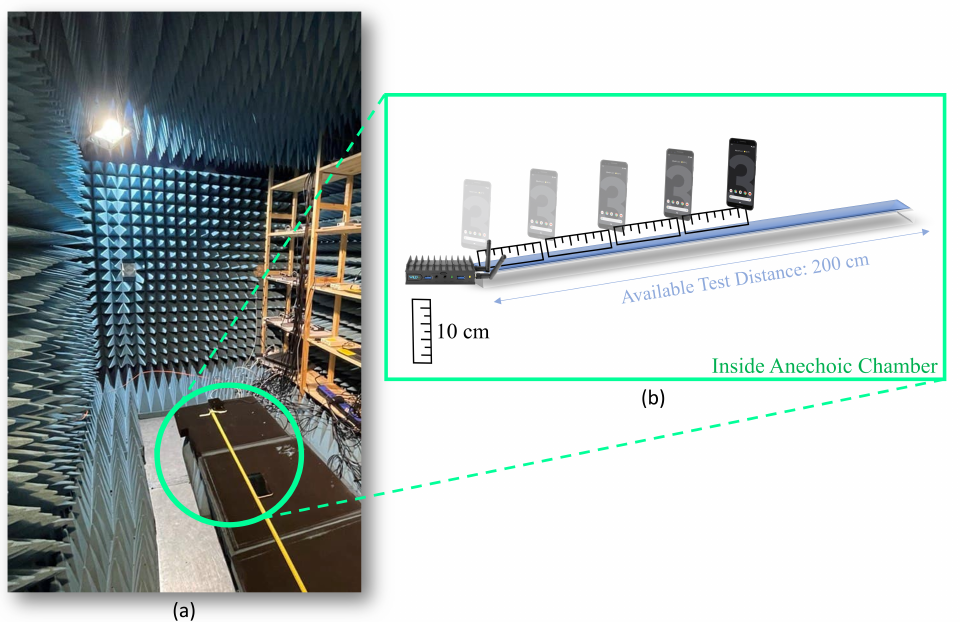
Figure 3. ( a ) Measurement setup in the anechoic chamber. ( b ) Data collection for model